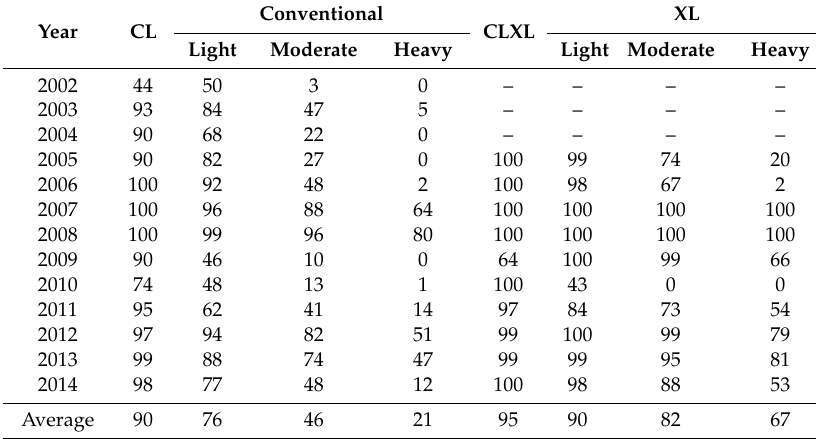
Table 4. Percentage of simulated yearly observations where revenue exceeds costs for conventional, Clearfield ® (CL), hybrid (XL), and Clearfield ® hybrid (CLXL) rice under the light, moderate, and heavy levels of initial red rice infestation: